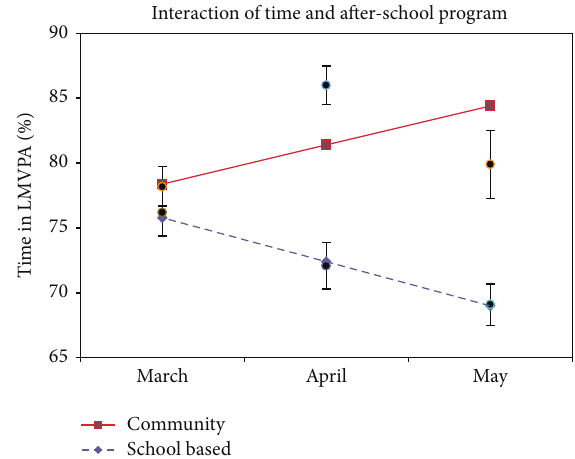
Figure 2: Percent of time spent in moderate/vigorous physical activity (MVPA) after-school. Notes: lines show mixed model outcome slopes; points show observed means ± standard